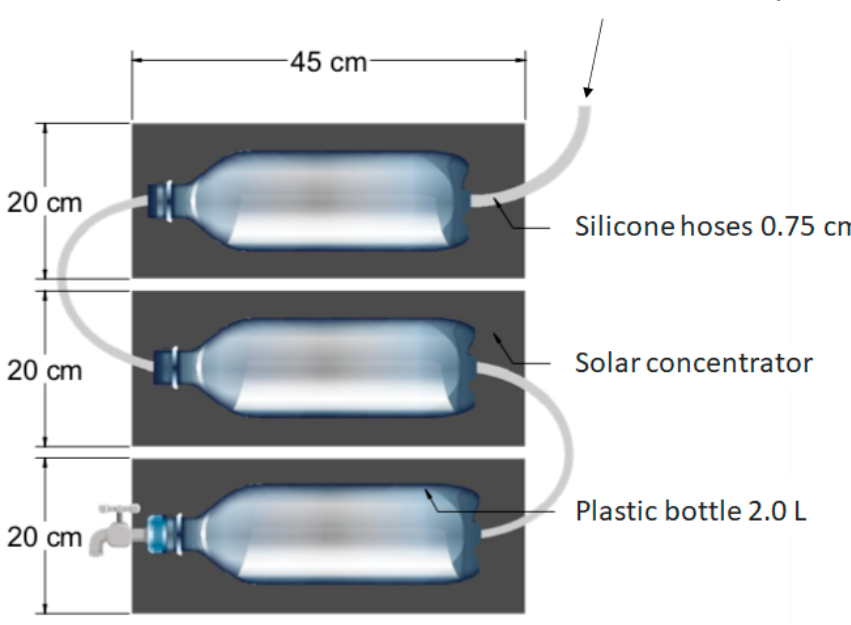
Figure 1. Solar disinfection (SODIS) system schematic